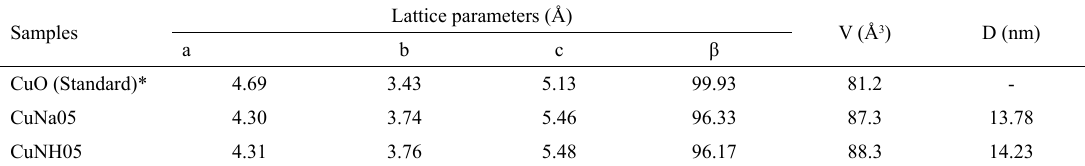
Table 1. Lattice parameters, unit cell volume (V) and crystallite size (D) of both CuNa05 and CuNH05 samples. Samples